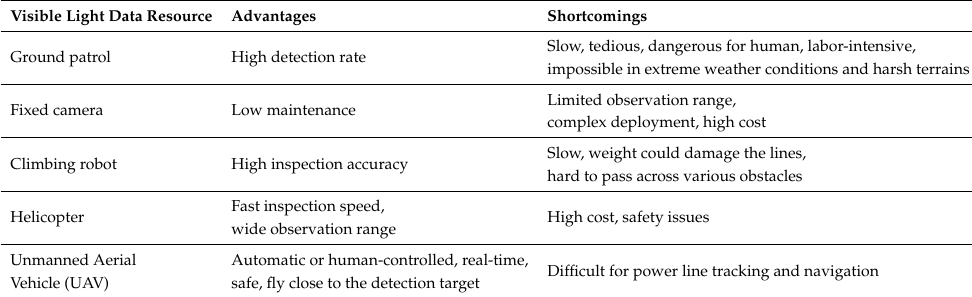
Table 4. Platforms For collecting visible light